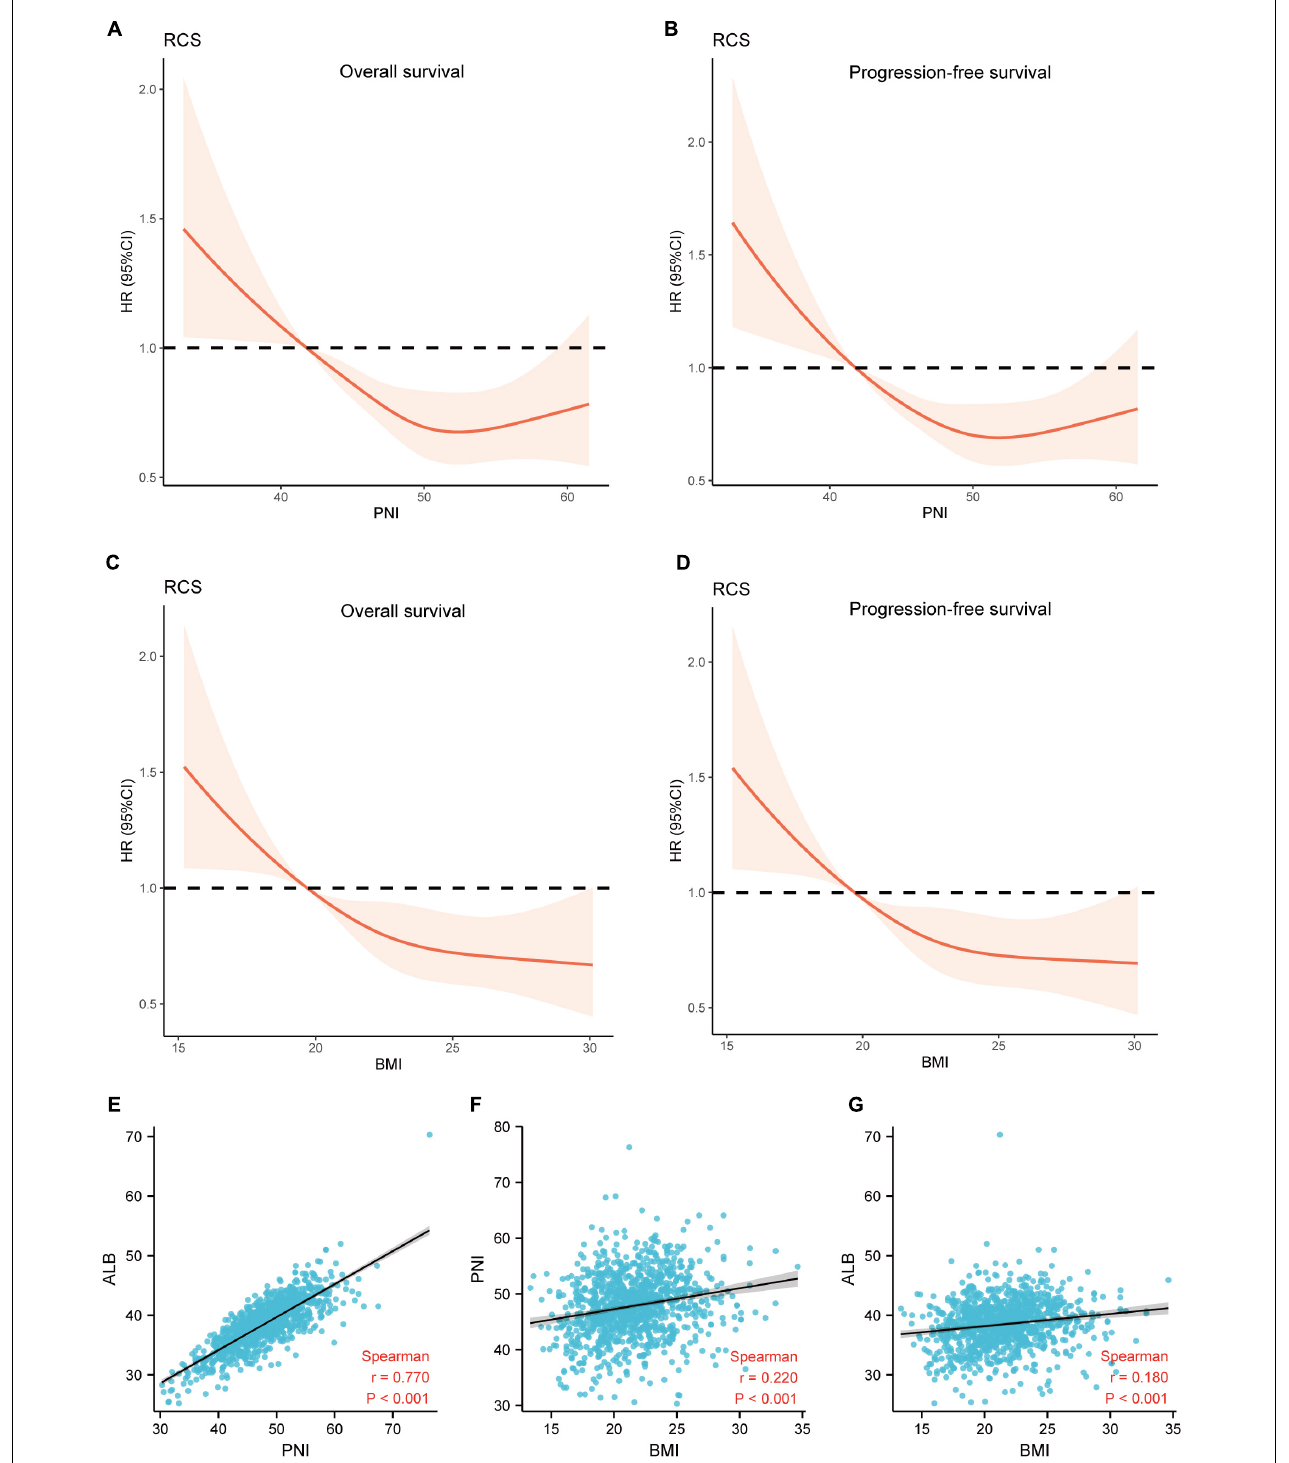
FIGURE 6 | The relationship between the nutritional indices and survival. (A,B) A non-linear relationship between the PNI and survival for patients with ESCC. The death hazard of PNI sharply decreased at 41.8; (C,D) a linear relationship between the BMI and survival, with an inferior OS and PFS when a decrease in the PLR at 19.7; (E) the correlation between PNI and ALB (Cor = 0.770, p < 0.001); (F) the correlation between BMI and PNI (Cor = 0.220, p < 0.001); (G) the correlation between BMI and ALB (Cor = 0.180, p < 0.001). OS, overall survival; PFS, progression-free survival; PNI, prognostic nutritional index; ALB, albumin; Cor, correlation; BMI, body mass